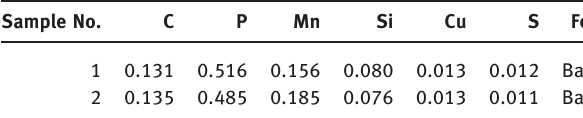
Table 1: Chemical compositions of the experimental steels [wt%]. Sample